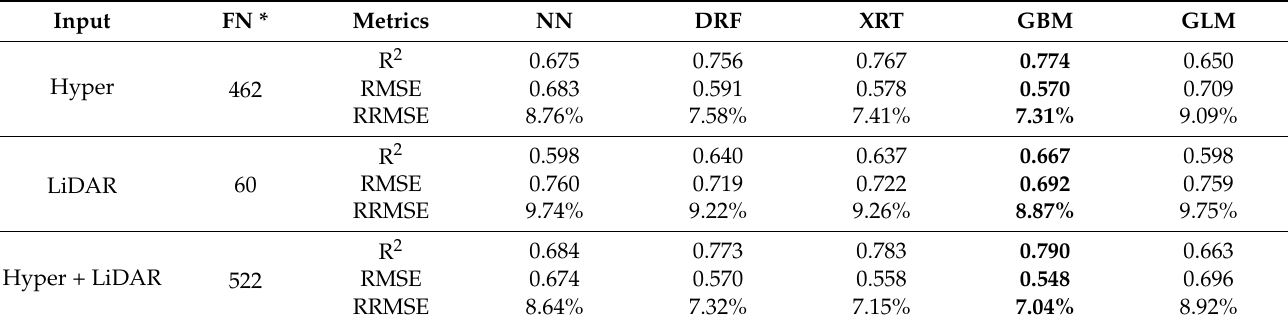
Table 8. Validation statistics of corn protein concentration estimation using five/different AutoML methods. Best prediction results are highlighted in bold.